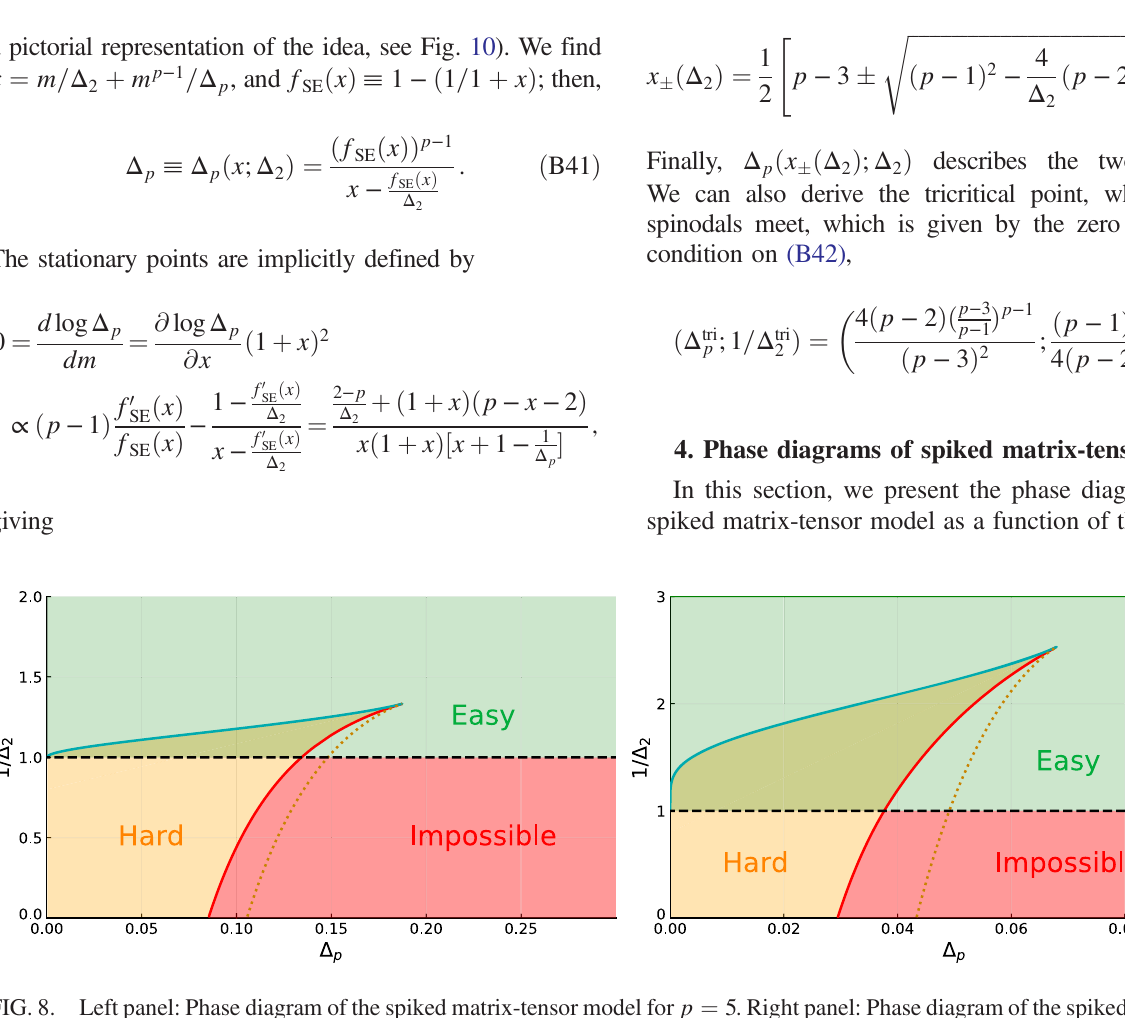
FIG. 8. Left panel: Phase diagram of the spiked matrix-tensor model for p ¼ 5 . Right panel: Phase diagram of the spiked matrix-tensor model for p ¼ 10 . In both cases, we observe qualitatively the same scenario found in the right panel of Fig.